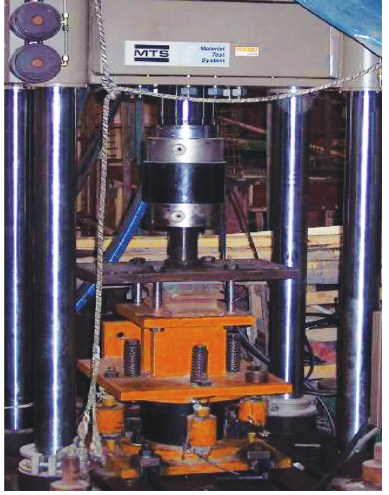
Fig. 2. Photograph of vertical loading test